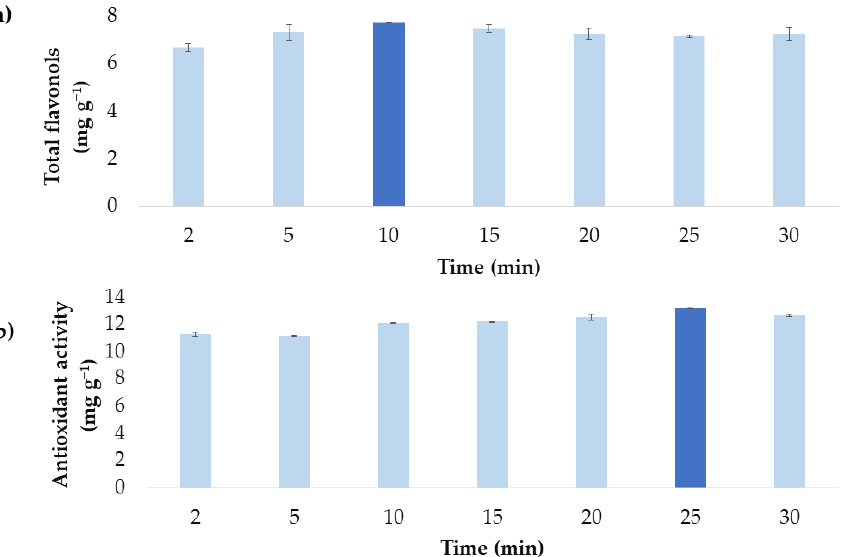
Figure 7. Effect of the extraction times on each optimized MAE method: ( a ) optimized MAE method for the maximum extraction of total flavonols and ( b ) optimized MAE method for extracts with maximum antioxidant activity. Each extraction time was used in three tests (mean ± SD) and the statically significant differences between the times according to Tukey’s test are indicated by the different letters over the corresponding column.